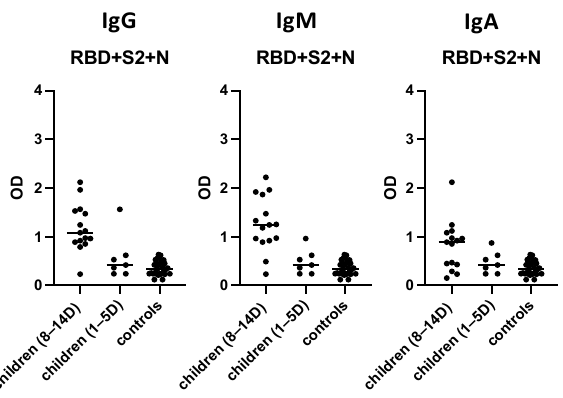
Figure 8. Immunoreactivity of sera from children with PCR-confirmed COVID-19 and controls. Sera were used at a 1:100 dilution using the “in-house” ELISA where the combination of 3 different proteins (RBD 2.5 µ g/mL, S2 1 µ g/mL, N 1.5 µ g/mL) was used as the capture antigen. Black symbols represent the Optical Density (OD) value of each serum at 405 nm.